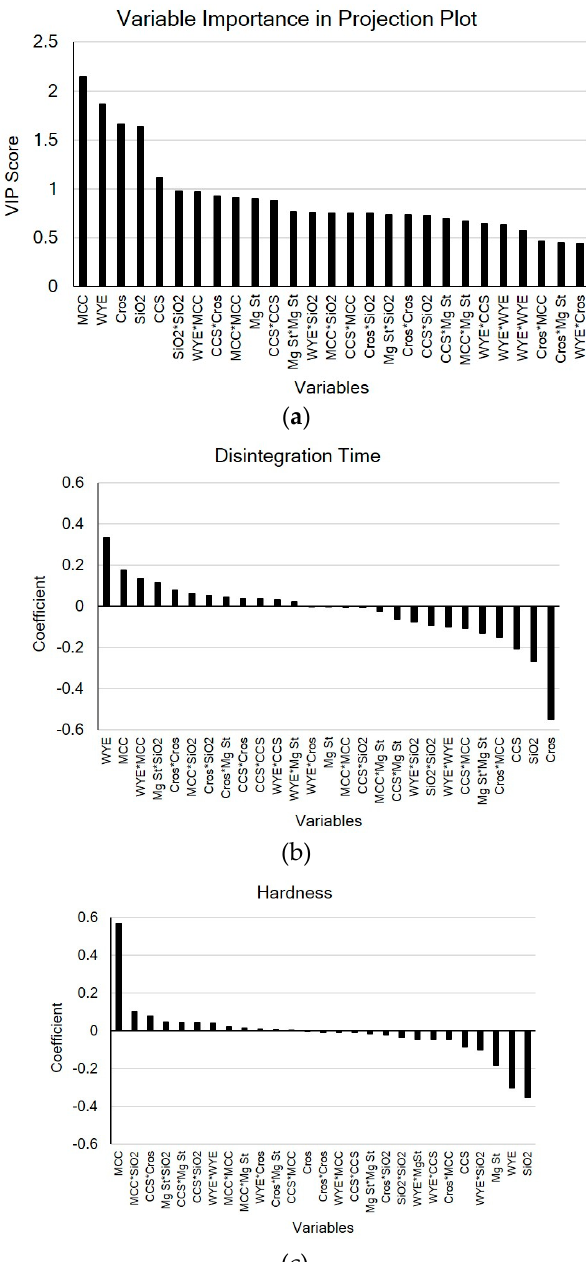
Figure 4. The variable importance in projection (VIP) plot ( a ) displaying important variables in terms of disintegration time and hardness; and coefficient plots for ( b ) disintegration time; and ( c ) hardness.